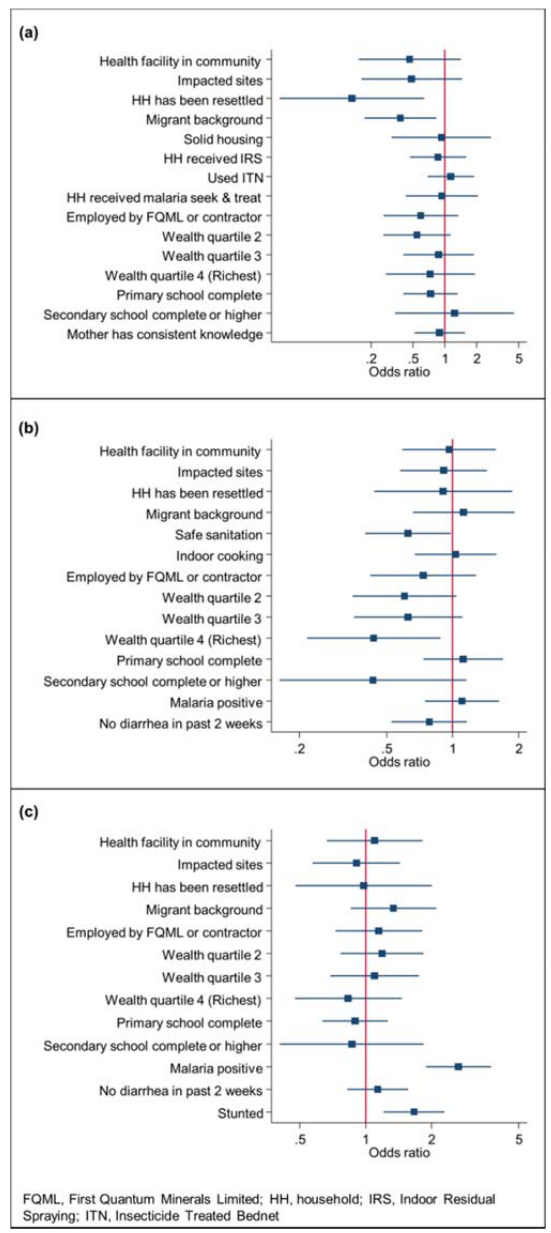
Figure 4. Determinants of health outcomes during the 2015 follow ‐ up health survey, with adjusted odds ratios and 95% confidence intervals, Trident project, Zambia: ( a ) determinants of P . falciparum in children aged 6–59 months; ( b ) determinants of stunting in children aged 0 ‐ 59 months; and ( c